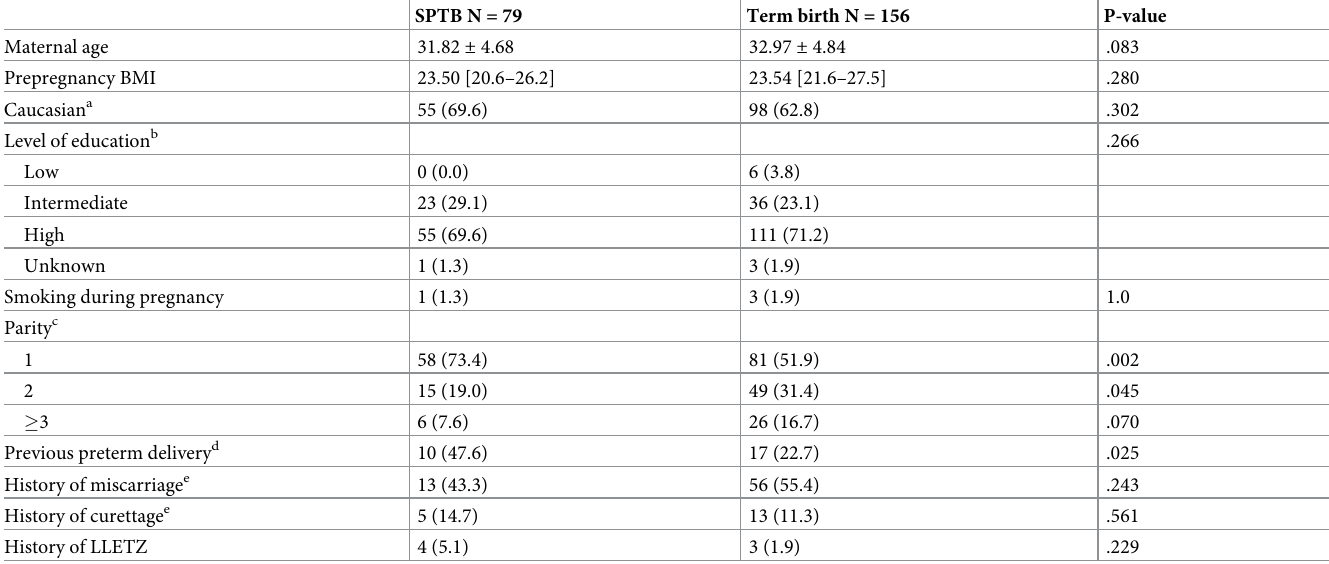
Table 1. Characteristics of the study population.